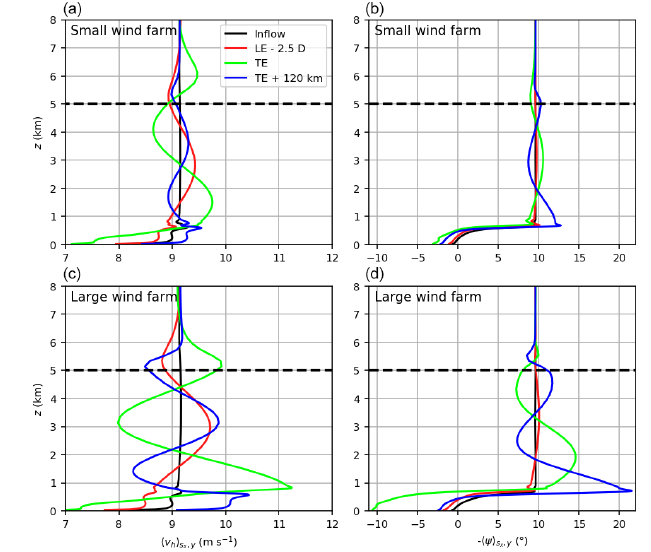
Figure 10. Vertical profiles of the horizontal wind speed (a, c) and the wind direction (b, d) for the small wind farm (a, b) and the large wind farm (c, d) . The profiles are averaged in time, along y and over one turbine spacing along x . Horizontal dashed line indicates the bottom of the Rayleigh damping layer.